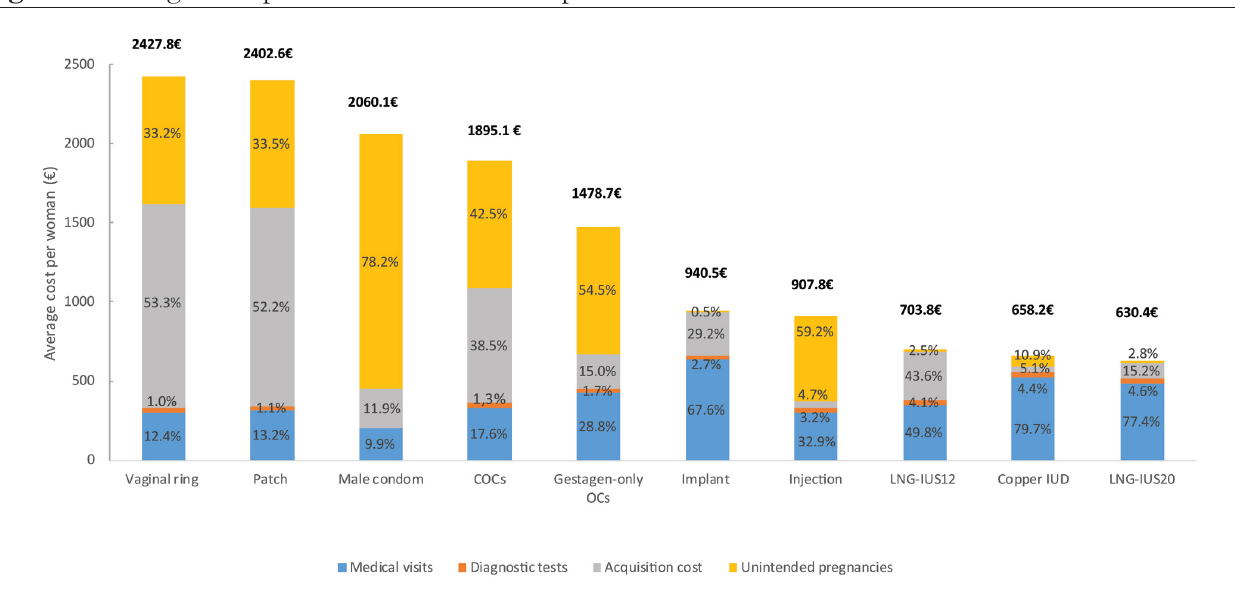
Figure 1. Average Cost per Woman and Contraceptive Method in a Period of 5 Years